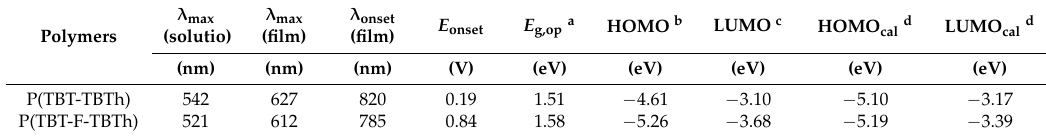
Table 1. Optical and electrochemical data of P(TBT-TBTh ) and P(TBT-F-TBTh ) .